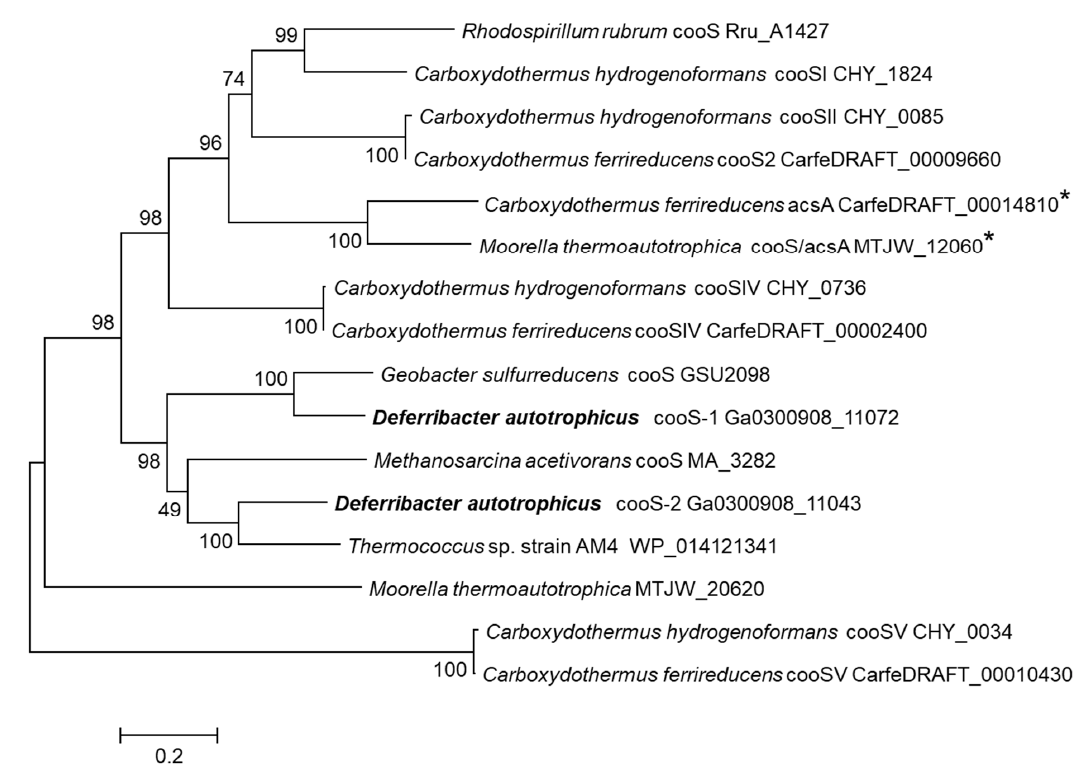
Figure 5. The phylogenetic tree of D. autotrophicus [Ni,Fe]-CODHs. The tree was constructed by the maximum likelihood method using MEGA7 [51] at default parameters after aligning the sequences with the built-in ClustalW at default parameters. Enzymes involved in the Wood–Ljungdahl pathway of acetyl-CoA synthesis from C1 units are marked with an asterisk.